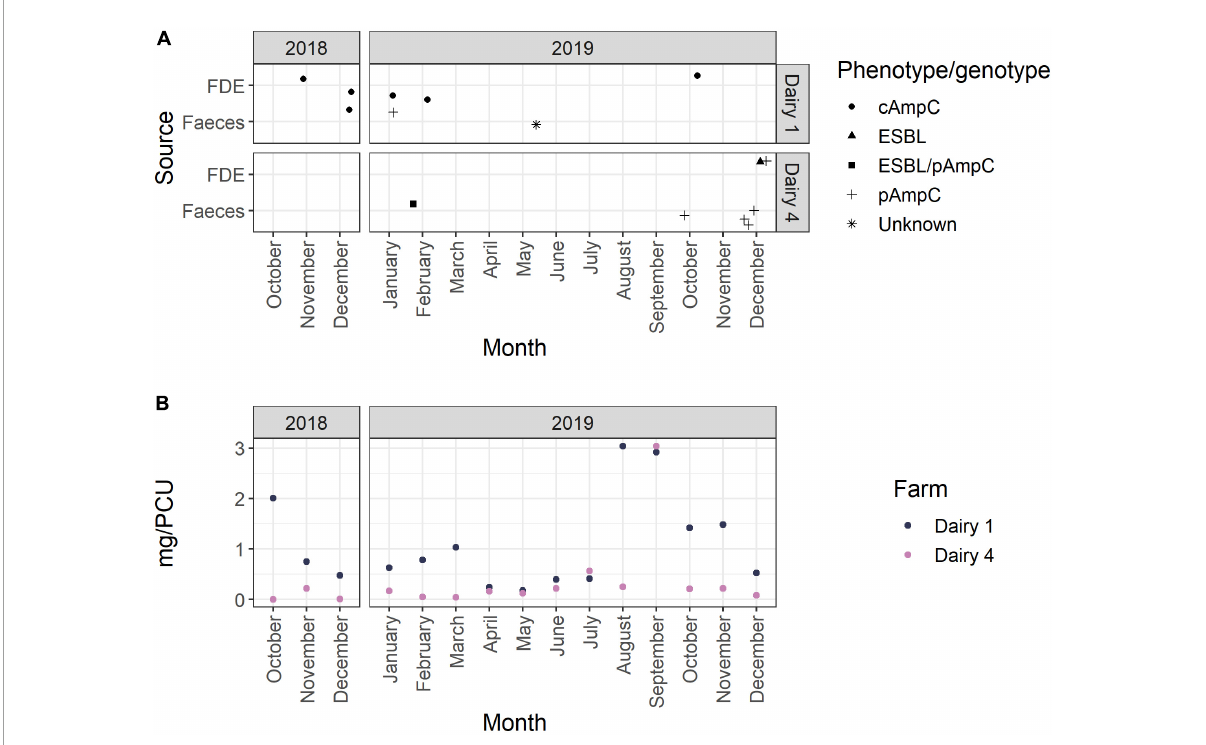
FIGURE4 (A) Collection dates of samples positive for ESBL- and/or AmpC-producing E. coli over the 15-month study period. The phenotype is represented by shape as indicated in the figure legend. (B) Antimicrobial use per month (mg active ingredient per population correction unit) on Dairy 1 and Dairy 4 during the 15-month study period.